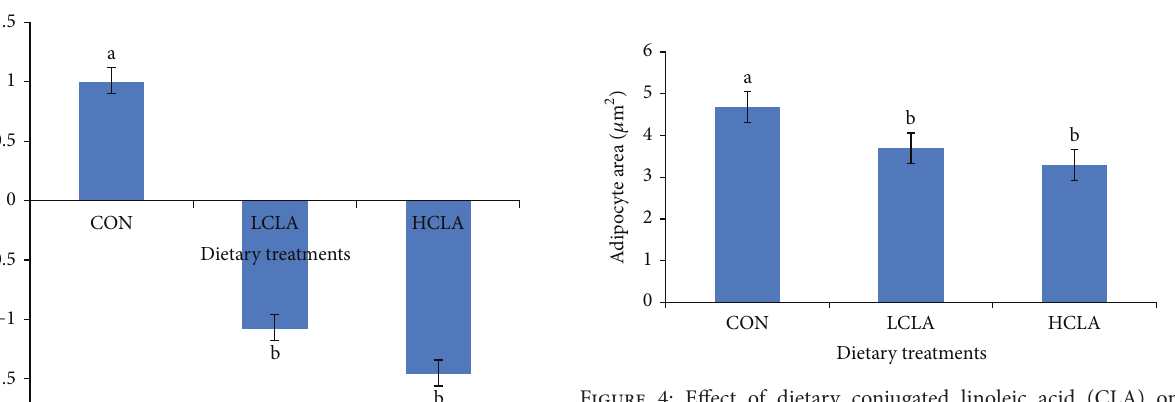
Figure 4: Effect of dietary conjugated linoleic acid (CLA) on adipocyte area distribution in the abdominal fat in chickens fed with CON (control), LCLA (low conjugated linoleic acid), and HCLA (high conjugated linoleic acid) for 6 weeks. Data represents the mean of cell area. Data are presented as mean ± SEM. Different superscripts within a cell size range denote significant differences ( 𝑃 < 0.05